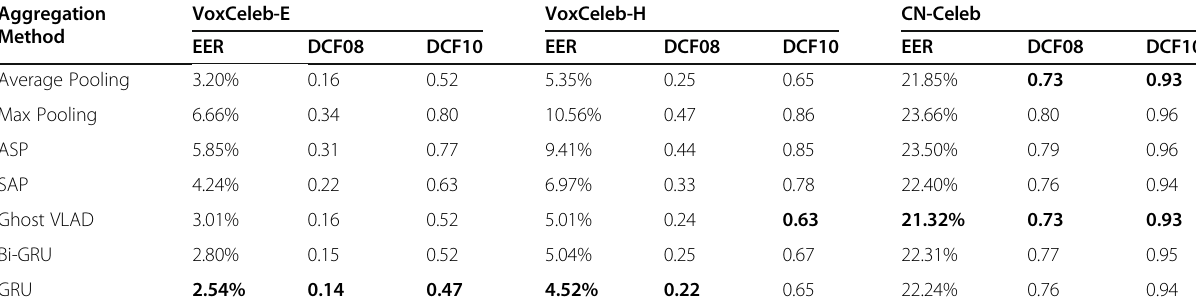
Table 6 The effect of different feature aggregation methods on recognition performance Aggregation